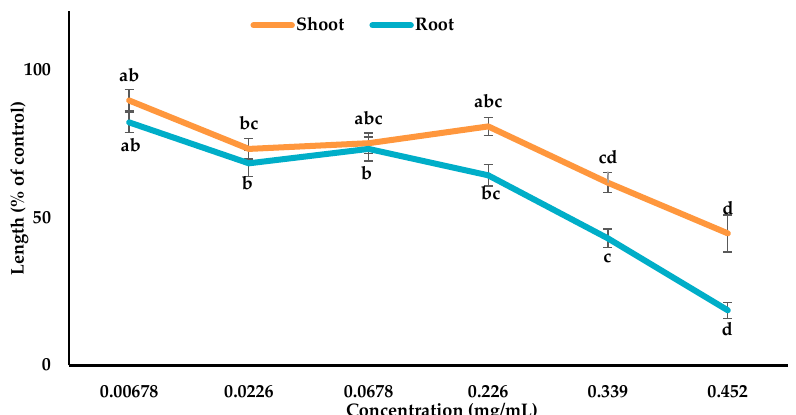
Figure 5. Phytotoxic potential of compound 1 against the shoot and root growth of Lepidium sativum . The values are the mean ± standard error (SE) from two different studies with 10 seedlings for each treatment. Different letters indicate significant variations according to Tukey’s HSD test at the 0.05 level of significance.